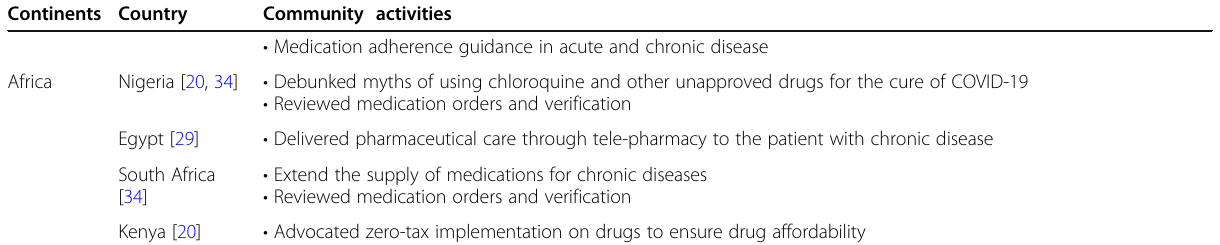
Table 1 Services provided by community pharmacists in tackling COVID-19 health crisis (Continued) Continents Country Community